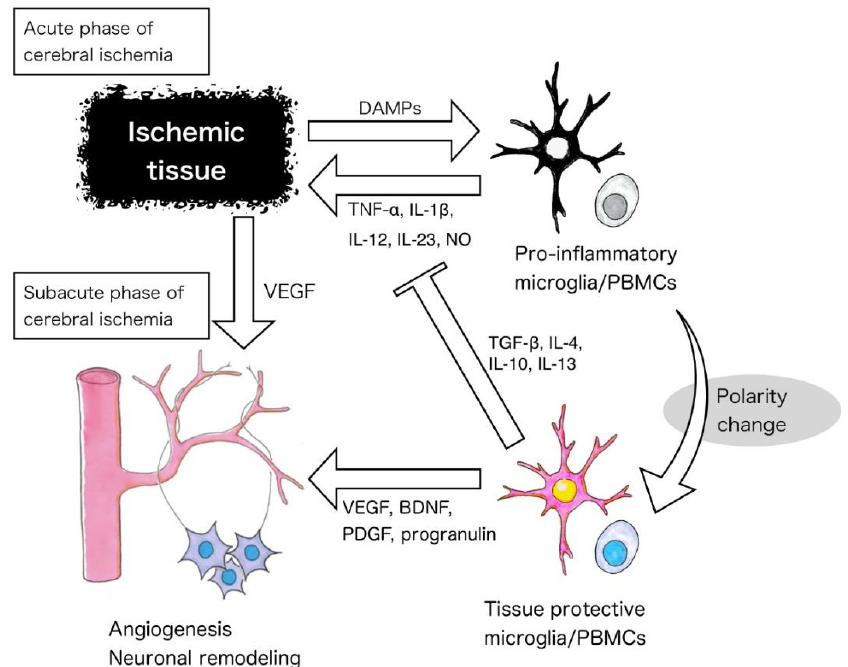
Figure 2. Mechanism of the therapeutic effects of microglia and peripheral mononuclear cells polarized to a tissue protective phenotype. DAMPs, damage-associated molecular patterns, TNF-α, tumor necrosis factor-α, IL, interleukin, PBMCs, peripheral blood mononuclear cells, TGF-β, transforming growth factor-β, VEGF, vascular endothelial growth factor, BDNF, brain-derived neurotrophic factor, PDGF, platelet-derived growth factor.